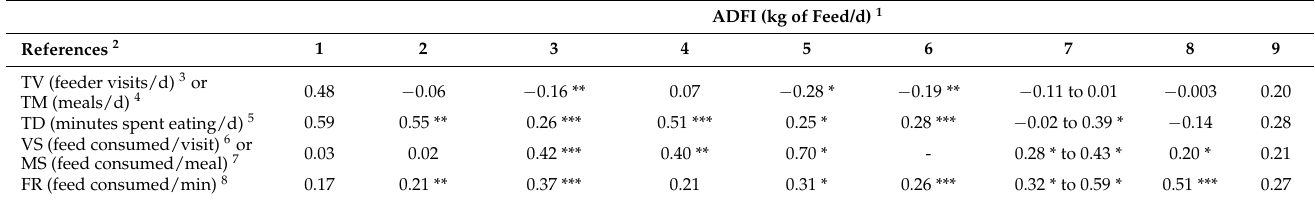
Table 7. Correlation results between feeding behaviour habits and average daily feed intake (ADFI).